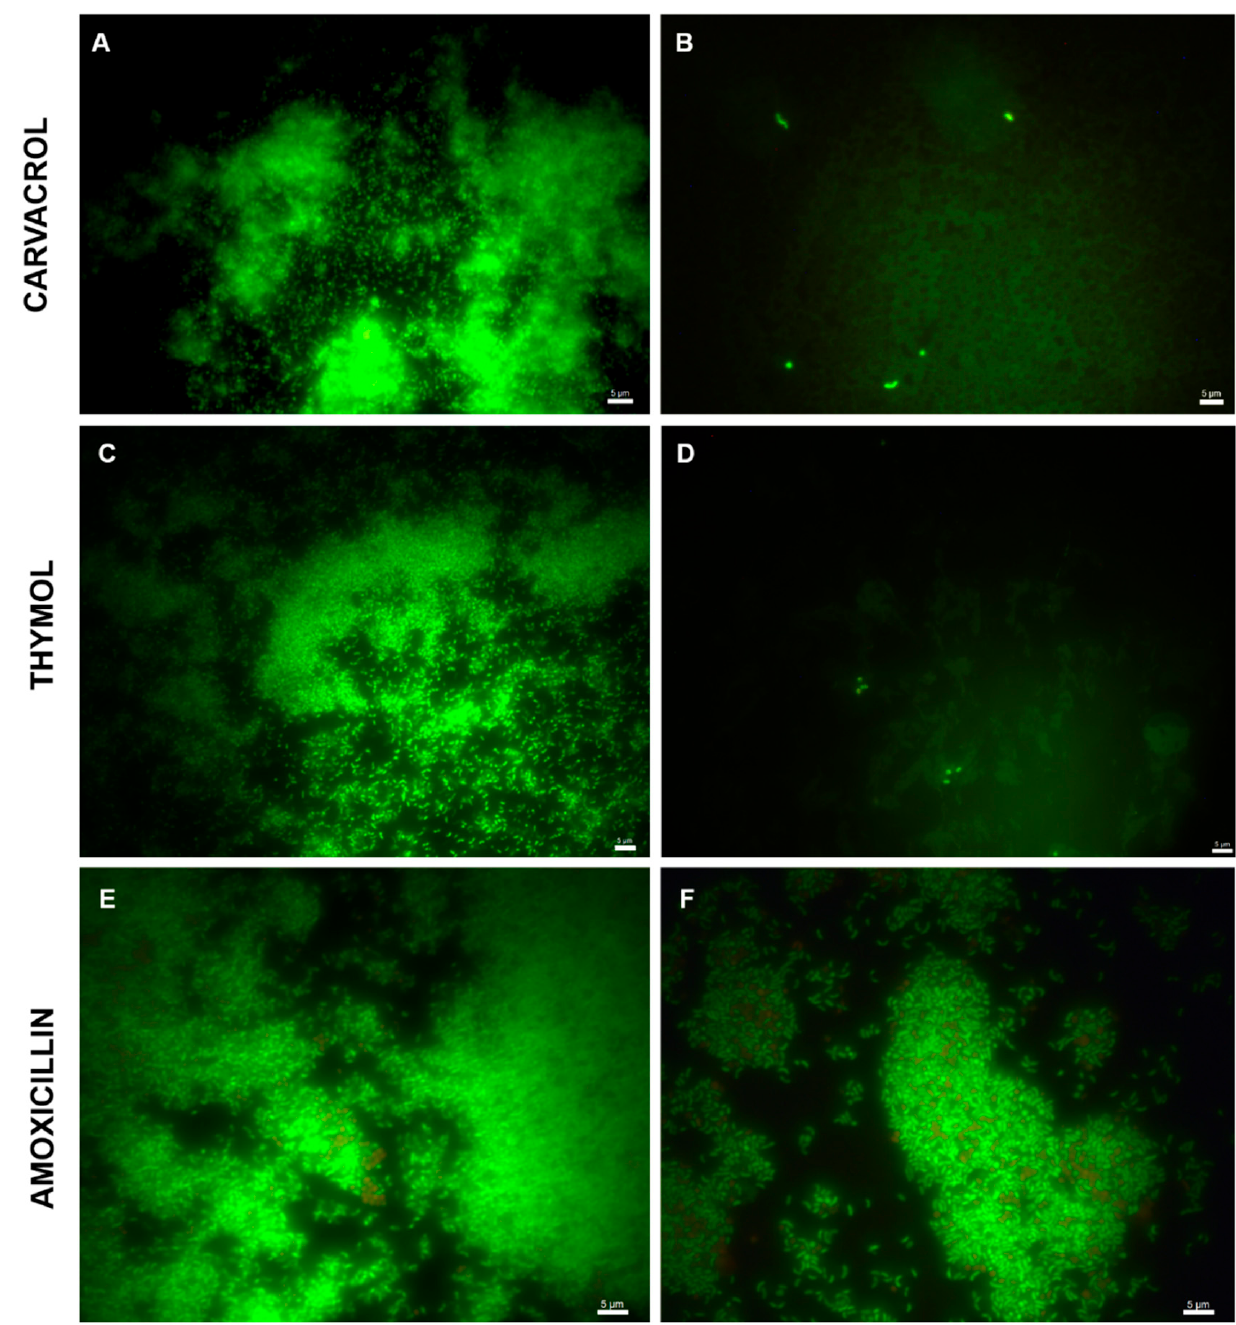
Figure 3. Representative images of H. pylori ATCC43629 biofilm after 72 h of incubation. The biofilms have been observed by using a fluorescence microscope. ( A , C , E ) untreated biofilm and ( B ) carvacrol-treated sample, ( D ) thymol-treated sample, and ( F ) amoxicillin-treated sample. Green fluorescence indicated the presence of live cells, and red fluorescence indicated the presence of dead cells. The presence of dead cells was negligible. Bar: 5 μ m.